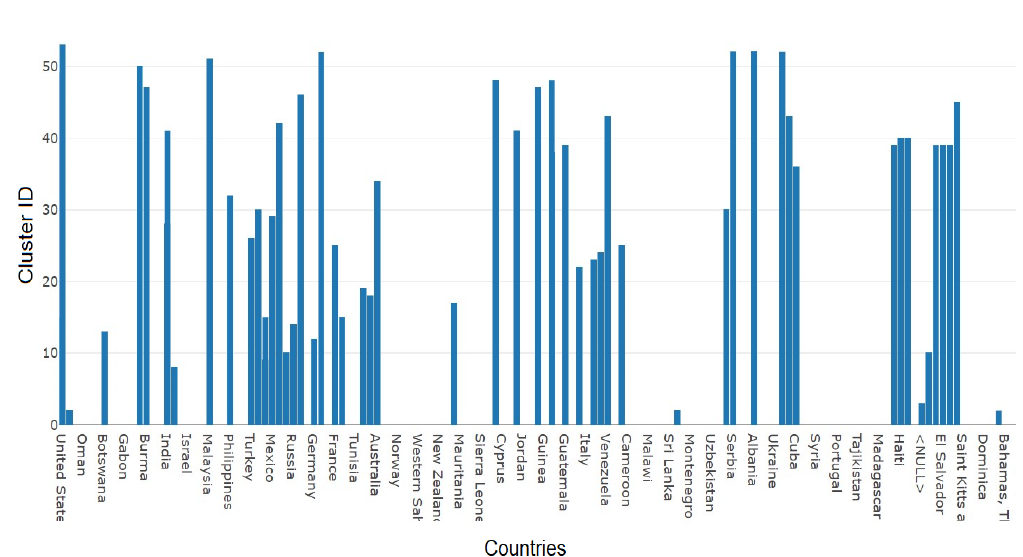
Figure 13. Bar plot generated between attributes “country” and “Cluster ID” to visualize which country belonging to the DBSCAN